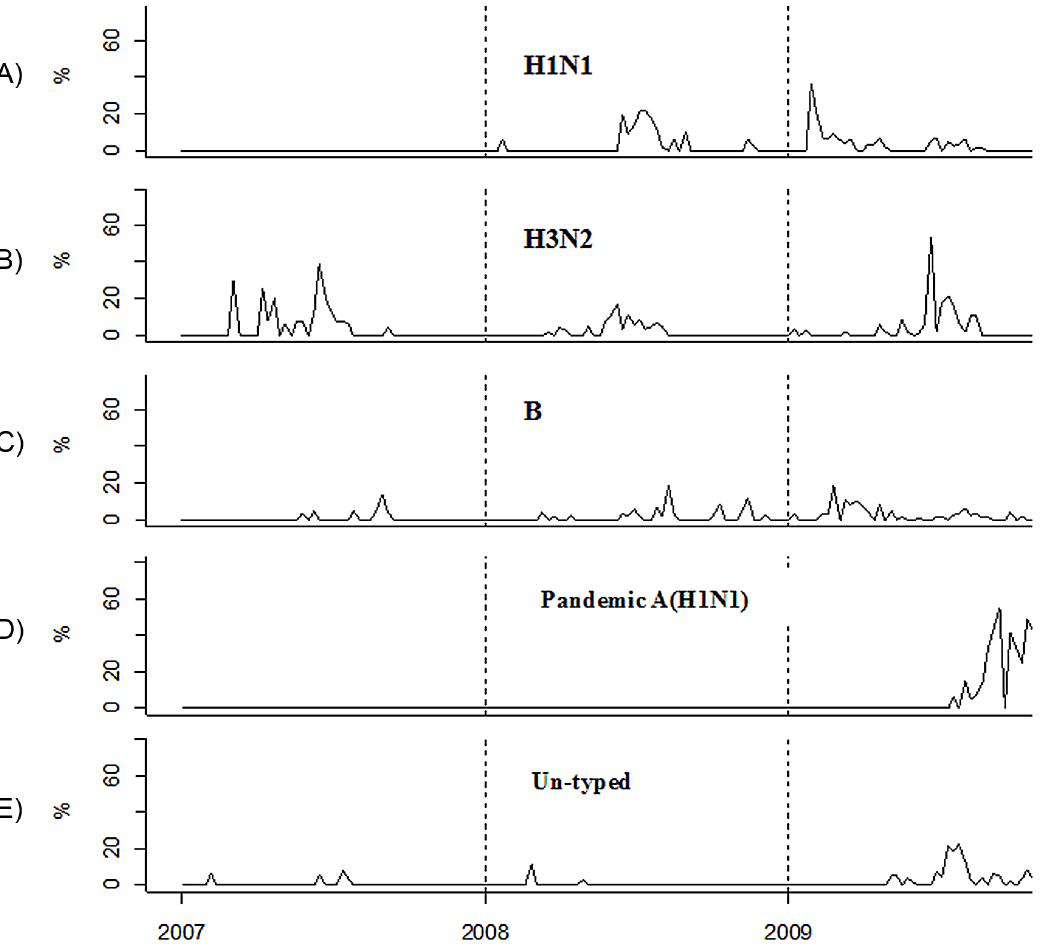
Fig 1. Seasonal transmission pattern of influenza viruses, 2007 – 2009. Three years of influenza pathogen surveillance data were collected in Zhuhai City, Guangdong Province, China. Specific patterns of seasonal transmission were observed in seasonal influenza A (H1N1, H3N2), influenza B, pandemic influenza A (H1N1), and untyped influenza viruses. The Y-axis refers to the isolation rate of influenza viruses, which is the proportion of the number of influenza virus – positive specimens to the total number of specimens